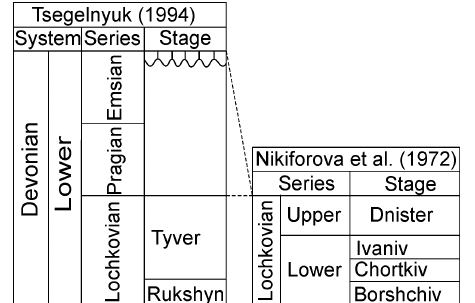
Fig. 2. Stratigraphic scheme of the Lower Devonian deposits of the Volyn-Podillyan Plate (after Nikiforova et al. 1972; Tsegelnyuk